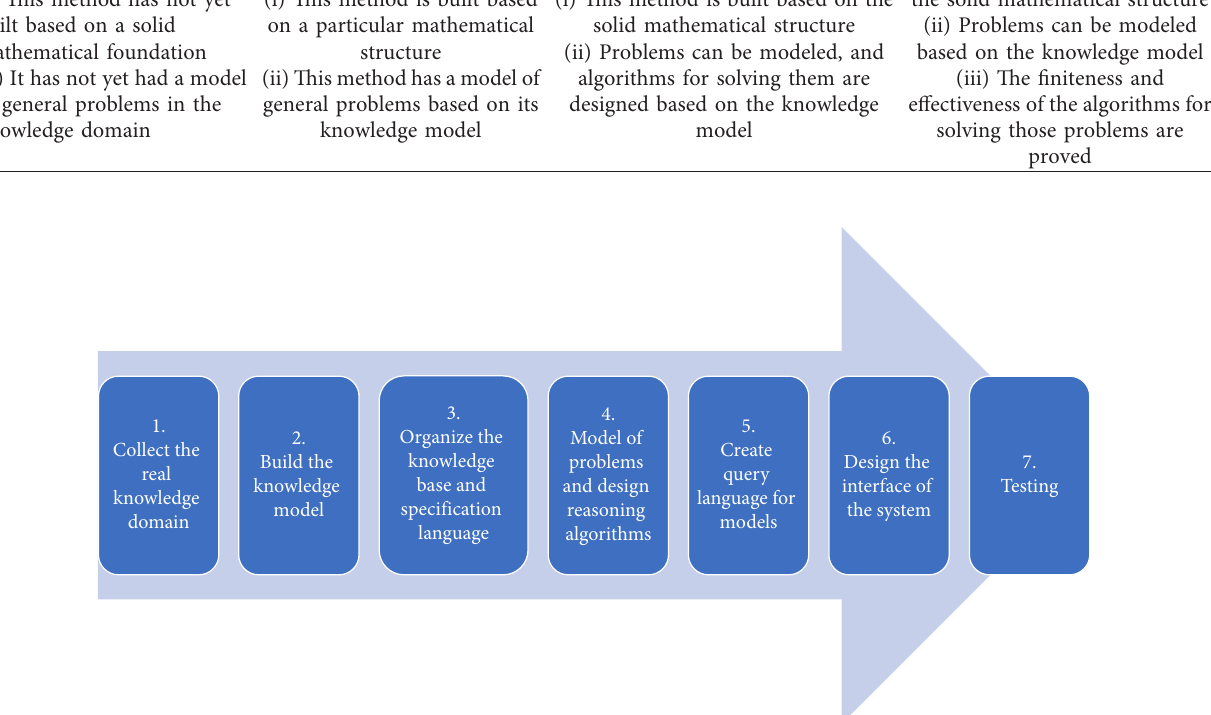
Figure 3: The process of designing an IPS in